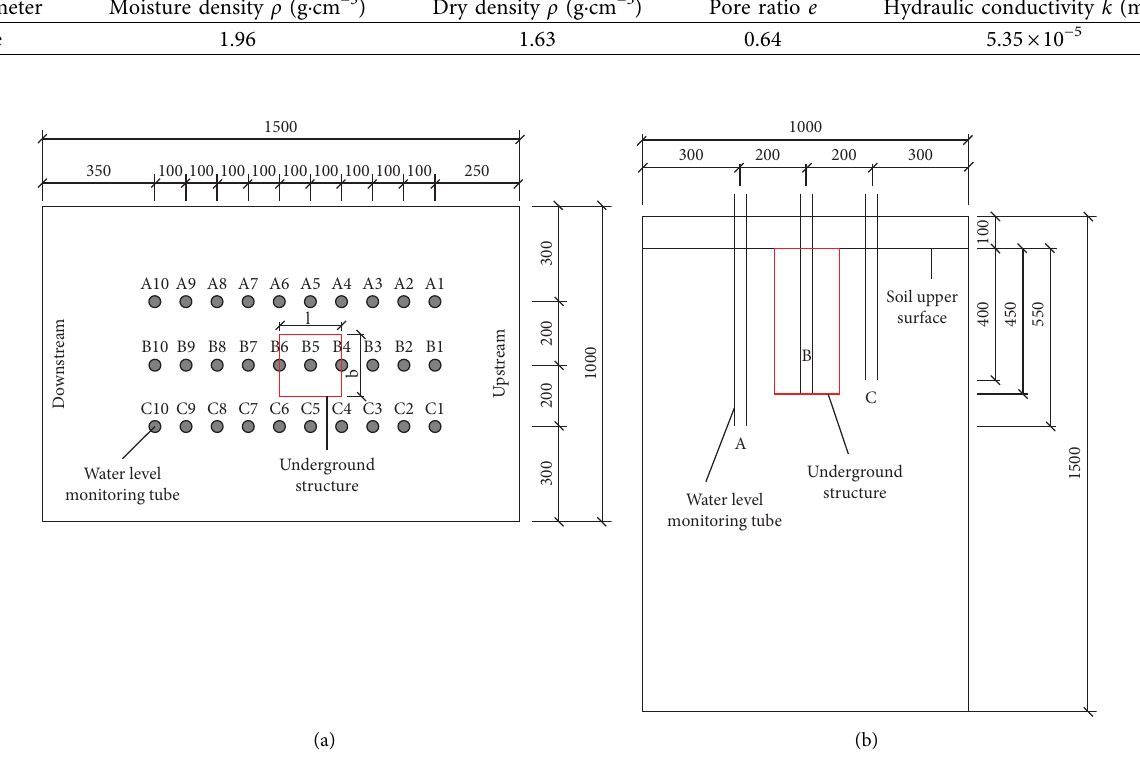
Figure 2: Te layout of the water level monitoring tubes (unit: mm). (a) Plan view. (b) Vertical view.